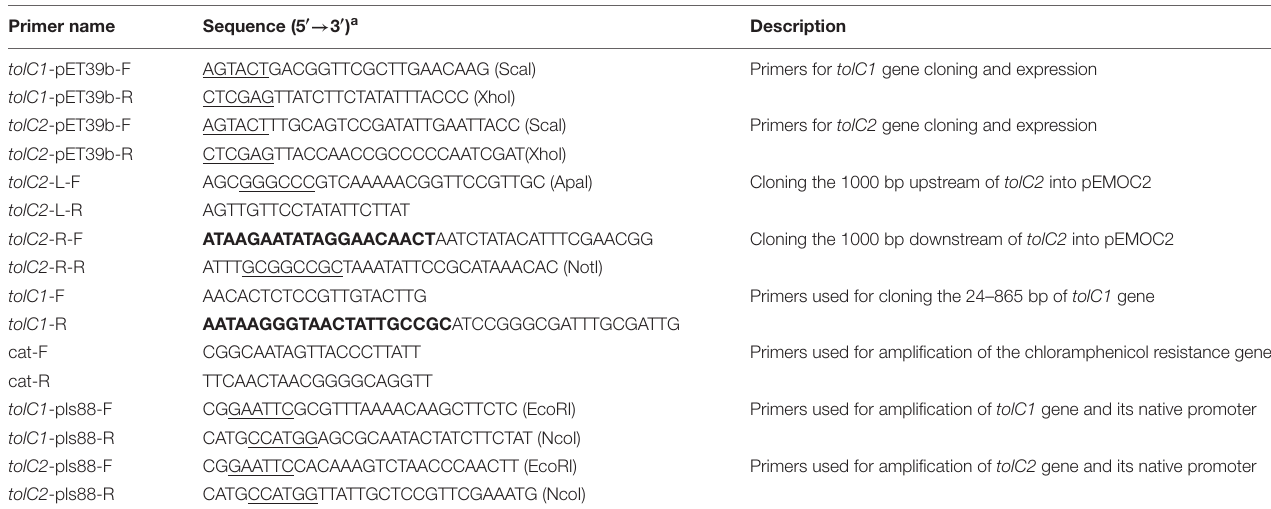
TABLE 2 | Primers used in this